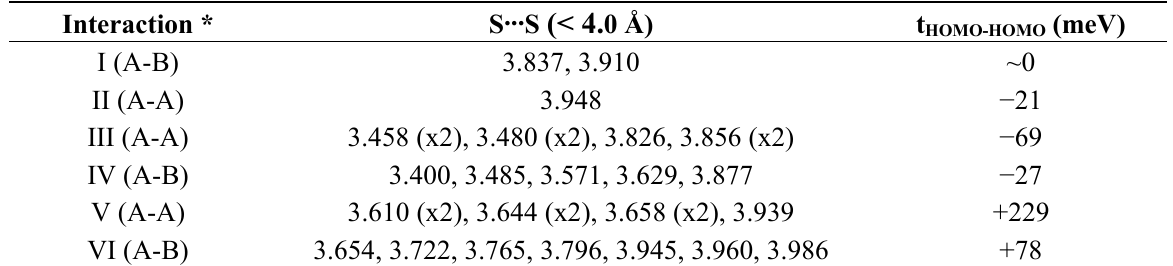
transfer integrals (meV) and S…S distances shorter than 4.0 Å for Table 2. t HOMO-HOMO